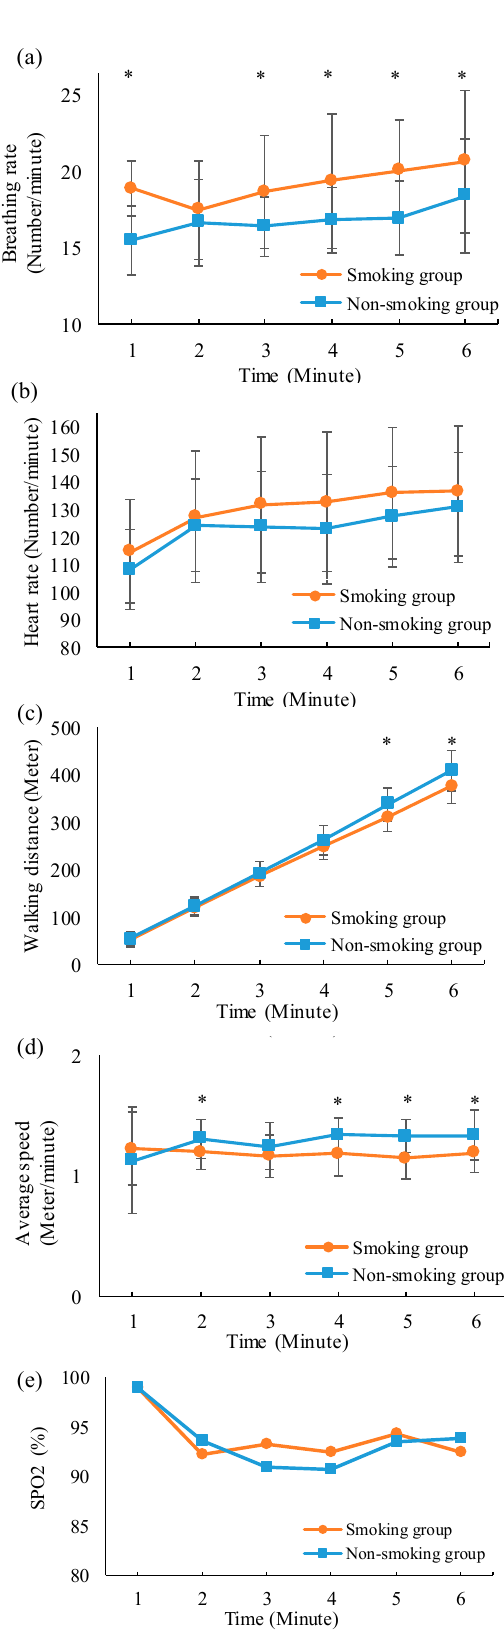
Figure 8. Changes in ( a ) breathing rate, ( b ) heart rate, ( c ) walking distance, ( d ) walking speed, and ( e ) SpO2 between different groups during the 6MWT. Here, * denotes that the difference between smoking and nonsmoking groups is significant ( p < 0.05).